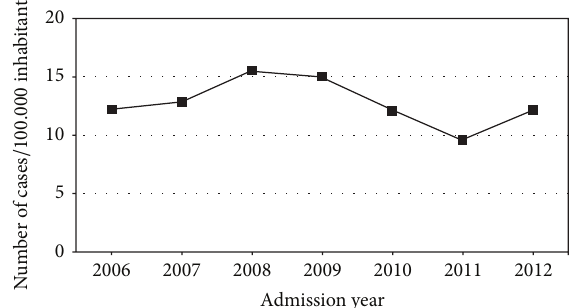
Figure 1: Annual hospitalization rates for peptic ulcer bleeding during seven years